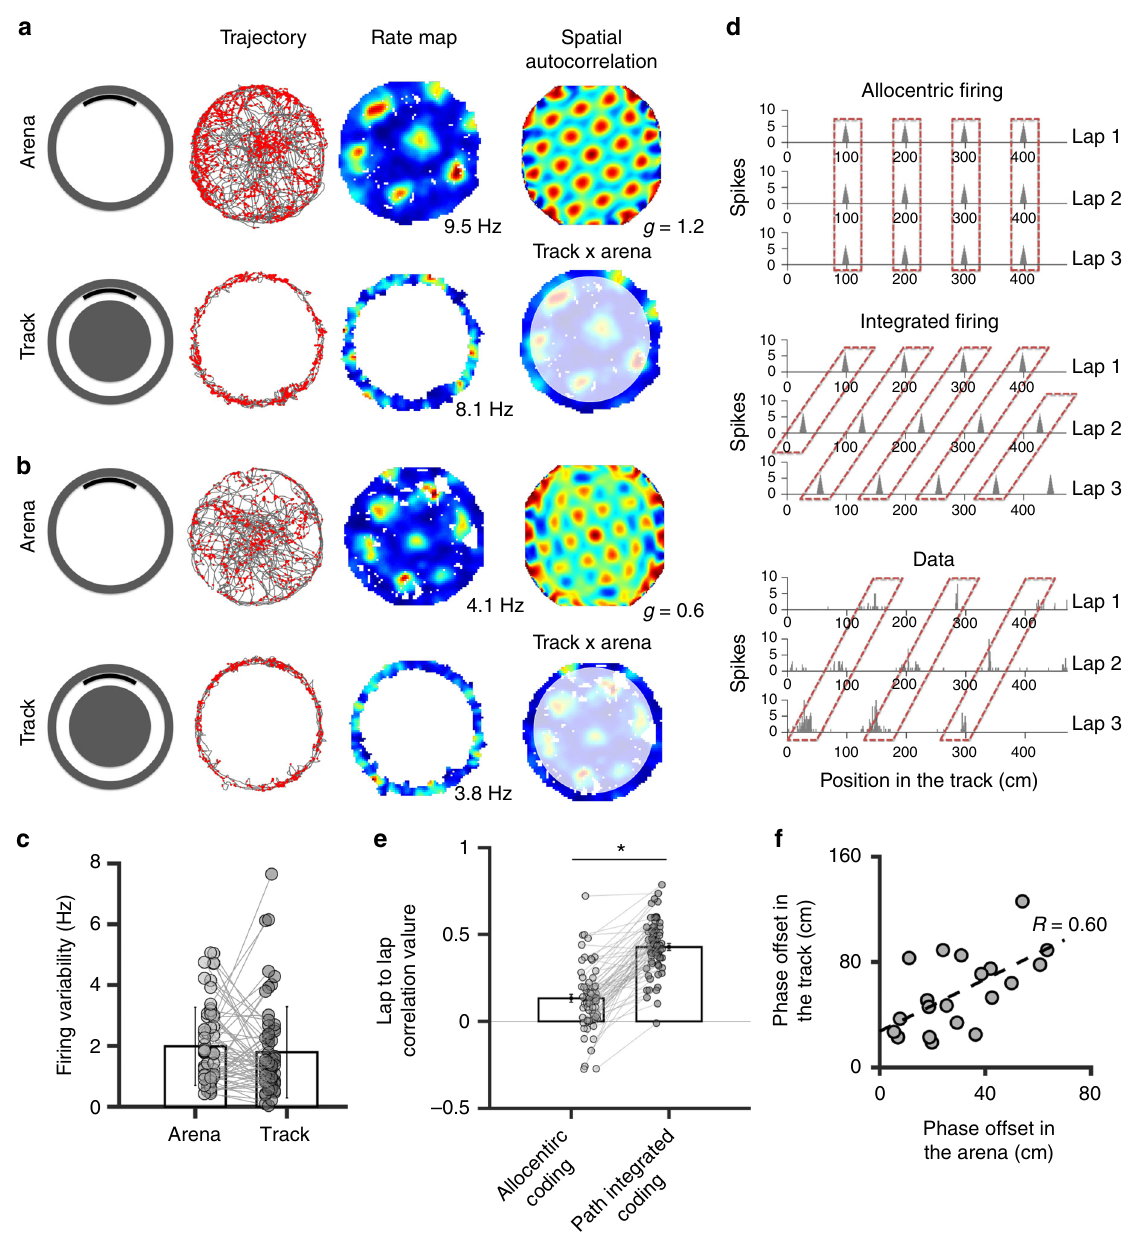
Fig. 2 Grid cell activity is linearized in the track. a , b Activity of two grid cells recorded in the arena and in the track. Top row: from left to right, rat trajectory (in grey) with spike locations (red dots), color-coded rate maps (the peak of the fi ring rate is indicated) and 2D autocorrelograms. ‘ g ’ indicates the gridness score. Bottom row: from left to right, rat trajectory with spike locations, color-coded rate maps observed in the track, and rate maps in arena in which the external area (equivalent to the track) is highlighted. Note that there is no correspondence between the maps in the track and the peripheral area of the arena. c Average fi ring fi eld variability (±SD) of grid cells in the arena and in the track. Data from individual cells are shown in grey. d diagrams showing rate plots of the activity of one hypothetical grid cell linearized in relation to the track position across three laps, according to the allocentric distance model (top, i.e. the position of the fi ring fi elds is stable across laps) and the path integrated distance model (middle, i.e. the position of the fi ring fi elds is shifted from one lap to the other). Bottom: activity from one grid cell recorded in the track; note that the position of the fi ring fi elds is consistent with the path integrated distance model. e Average correlation (±SEM) of grid cell activity across laps, according to the path integrated coding (i.e. the rate plot of one lap is shifted by a constant value with respect to the previous lap) and the allocentric coding (i.e. no shift between laps). Data from individual cells are shown in grey. * p < 0.05, paired t -test. f Scatter plots showing the relation between the phase offset of 20 pairs of simultaneously recorded grid cells in the arena and in the track. The Pearson correlation coef fi cient ‘ R ’ is